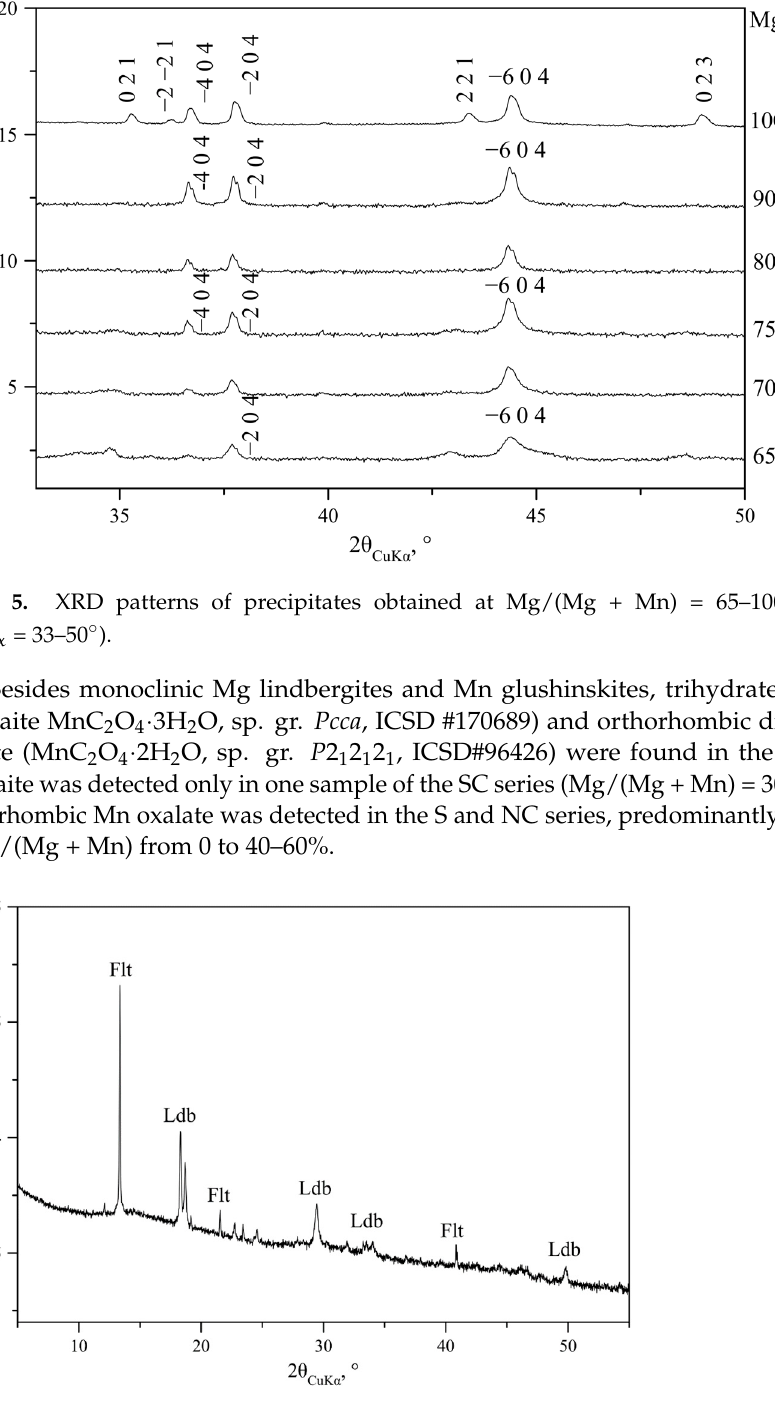
Figure 4. PXRD patterns of precipitates obtained at Mg/(Mg + Mn) = 40–80% (S series, 2 θ CuK α = 10– 35°). Notation: L—solid solution with lindbergite structure; G—solid solution with glushinskite structure; □ —peak of MnC 2 O 4 ∙ 2H 2 O phase (sp.gr. P 2 1 2 1 2 1 ); ○ —peak indicating formation of solid solution with glushinskite structure.